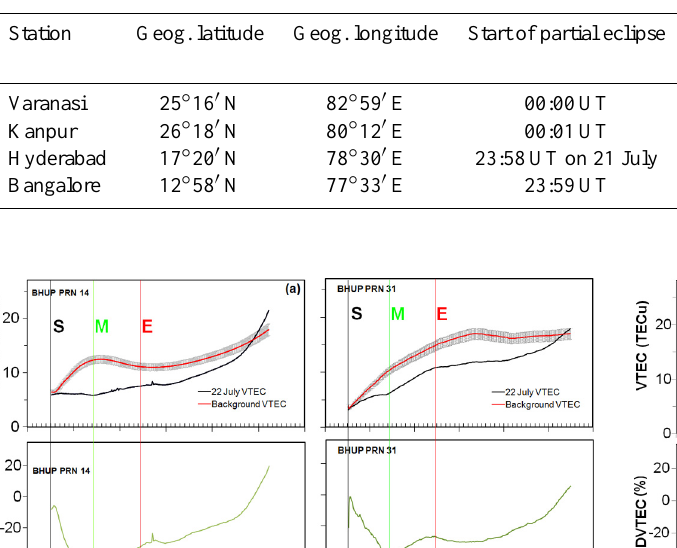
Table 1. Local circumstances for total solar eclipse on 22 July 2009 at all four locations.